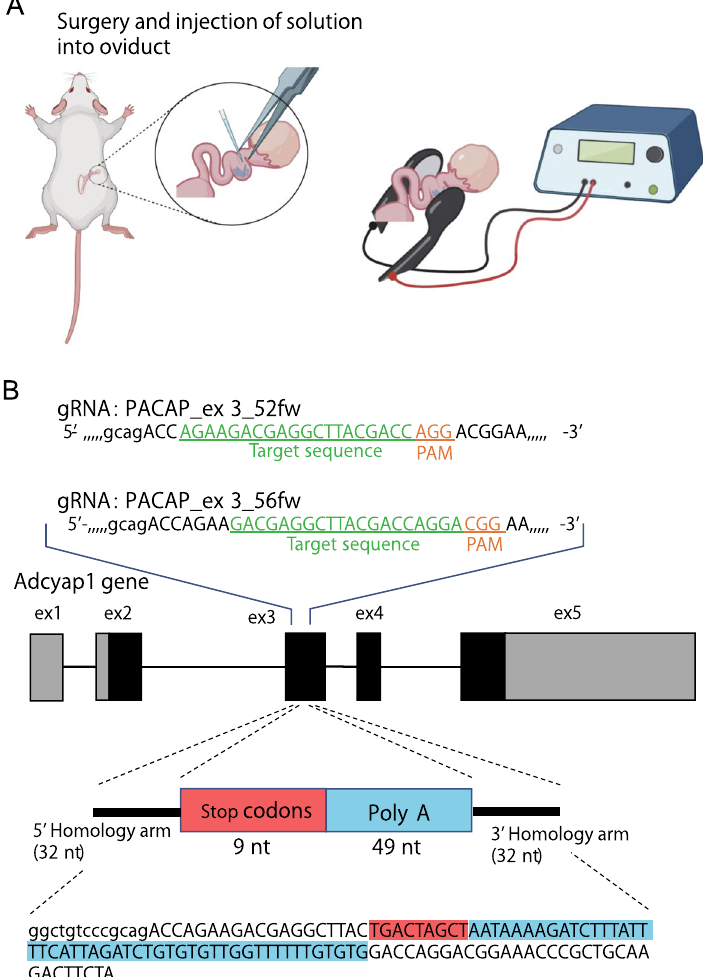
Figure 2. Overview of genome editing with the i -GONAD method. ( A ) An illustration of the procedure for the i -GONAD method. ( B ) Structure of the Adcyap1 gene and a design of the ssODN for knock-in of a null mutation by means of genome editing. In the Adcyap1 gene, filled boxes indicate exons, while black boxes indicate coding regions. The red box and sequence highlighted in red indicate triple stop codons in three coding frames. The last stop codon is overlapped with the following polyadenylation (poly-A) signal. The blue box and sequence highlighted in blue indicate the poly-A signal. Lowercase letters indicate the intron sequence, while uppercase letters indicate the exon sequence.